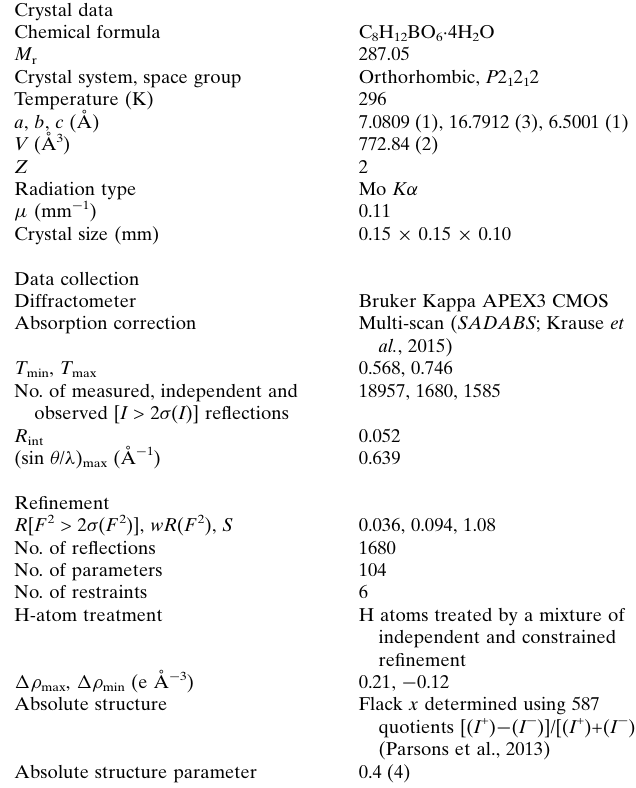
Table 2 Experimental details.